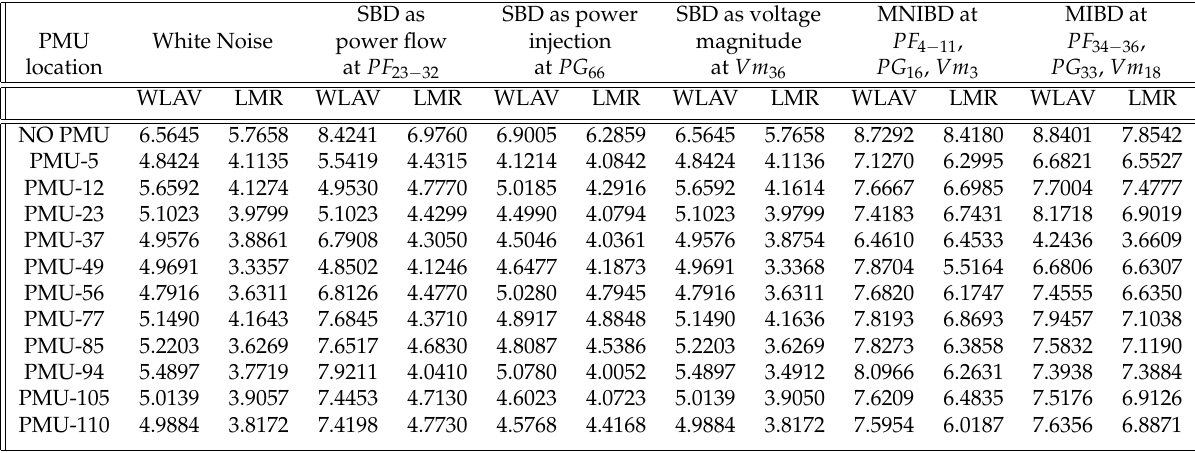
Table 11. IEEE 118 Bus - Absolute voltage angle (AVA)